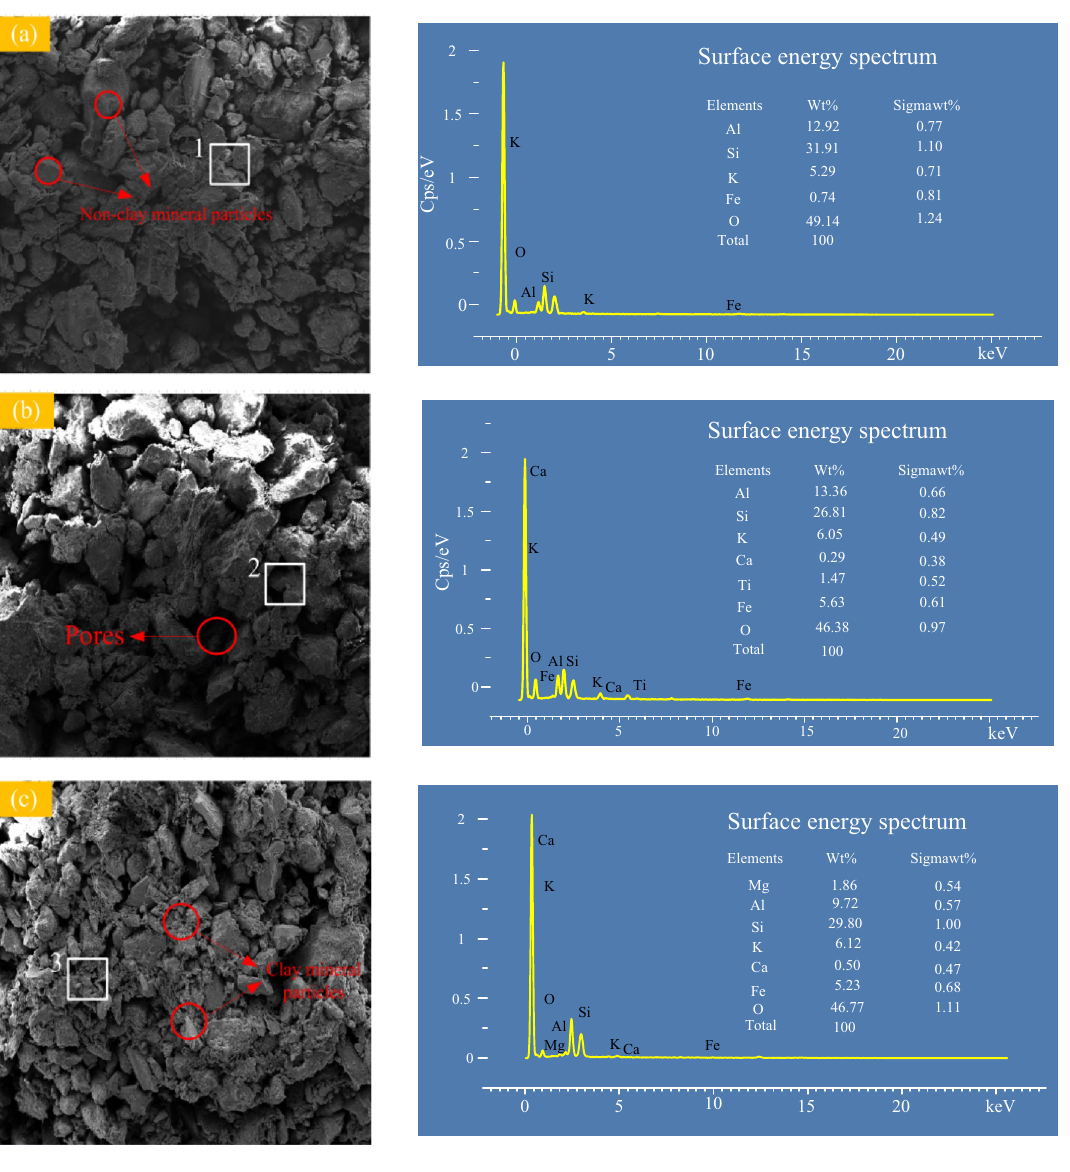
Figure 13. SEM images and energy spectrum of tailings. ( a ) CTI; ( b ) CTII; ( c )